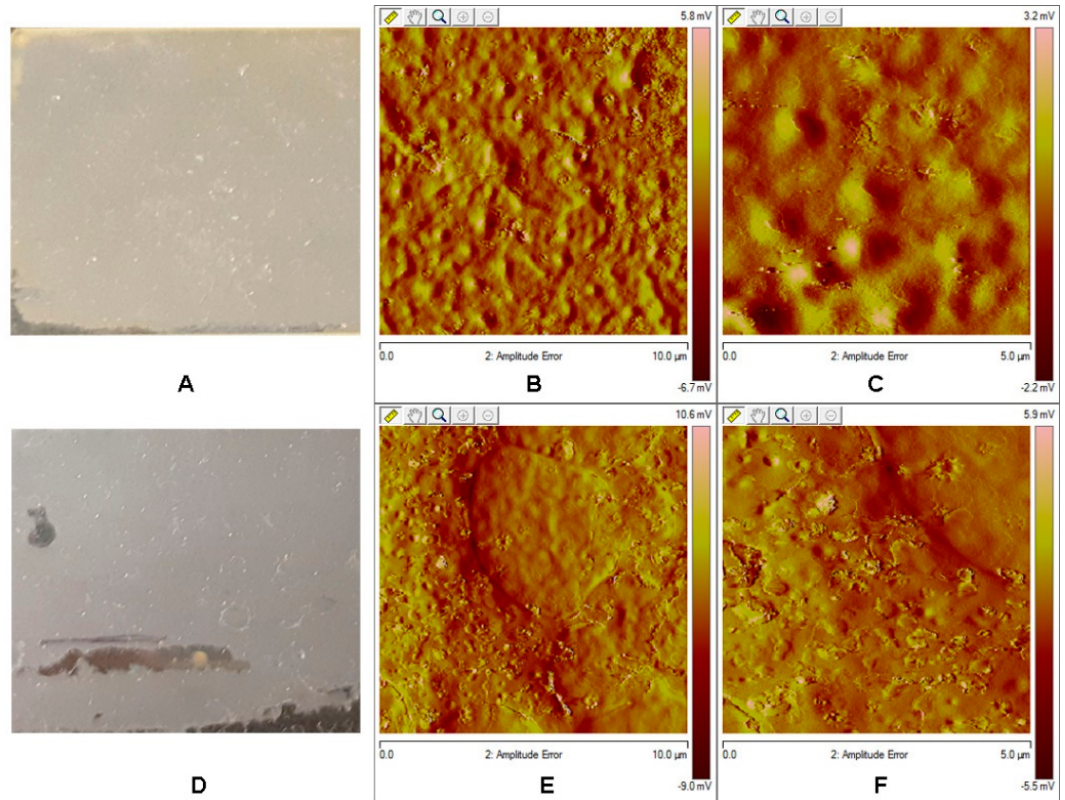
Figure 8. Atomic force microscopy tapping mode topographical images from ( A ) S. aculeatissimum ( B ) and ( C ): 5.0 and 1.0 µm, respectively) and ( D ) S. myriacanthum ( E ) and ( F ): 5.0 and 1.0 µm,